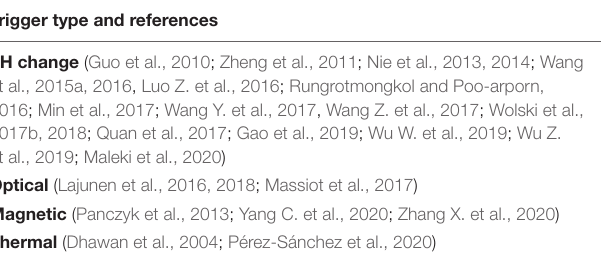
TABLE 1 | Triggers used to release drug